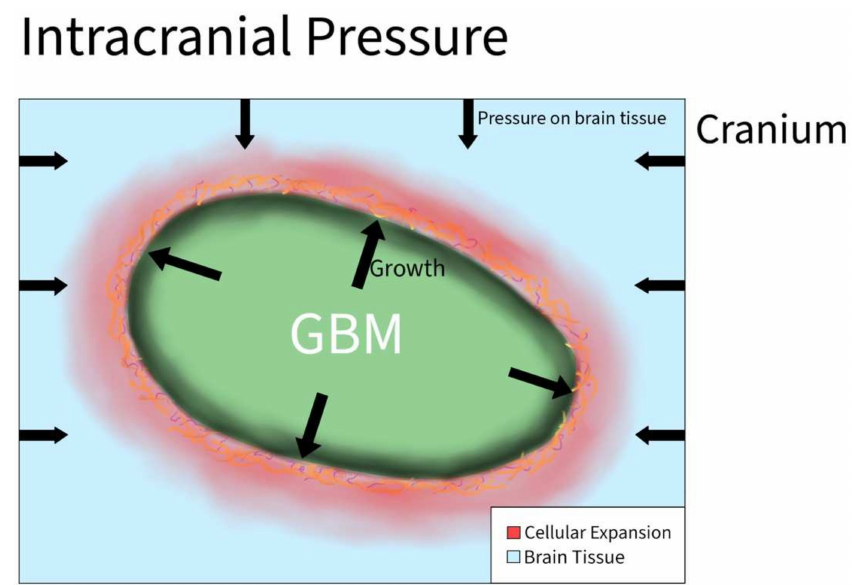
Figure 6. Intracranial Pressure in GBM. As the tumor grows rapidly inside the brain, the overall size of the brain increases and causes tissue to start pressing against the cranium. As a result, the cranium exerts compressive forces back on the brain that result in an increase in intracranial pressure.